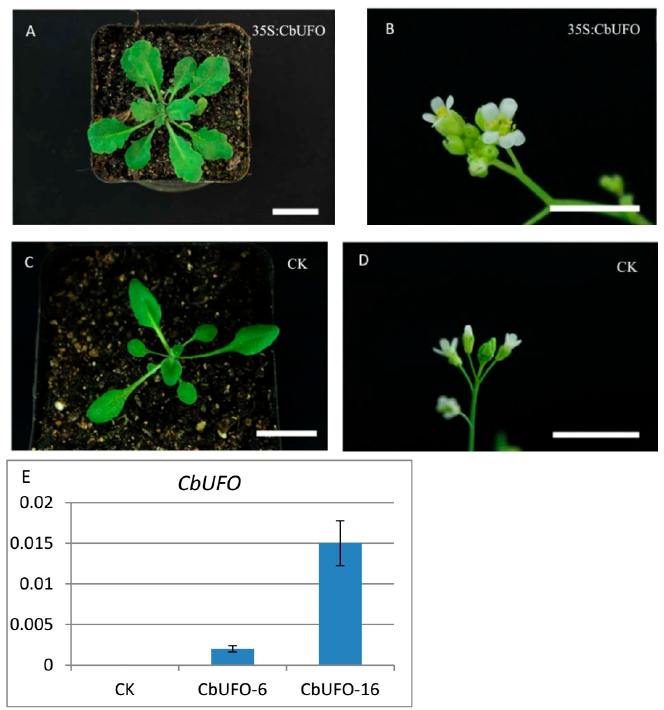
Figure 10. Phenotypes of 35S:CbUFO transgenic Arabidopsis T 2 lines and expression analysis of the